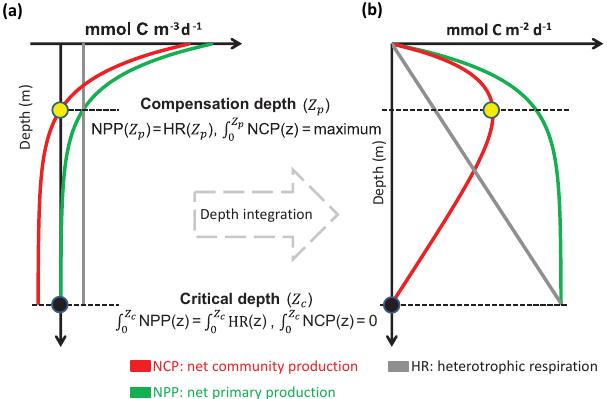
Figure 1. Schematic diagram of depth profiles of net community production (NCP), net primary production (NPP), and heterotrophic respiration (HR). Yellow and black dots represent the compensation and critical depths,